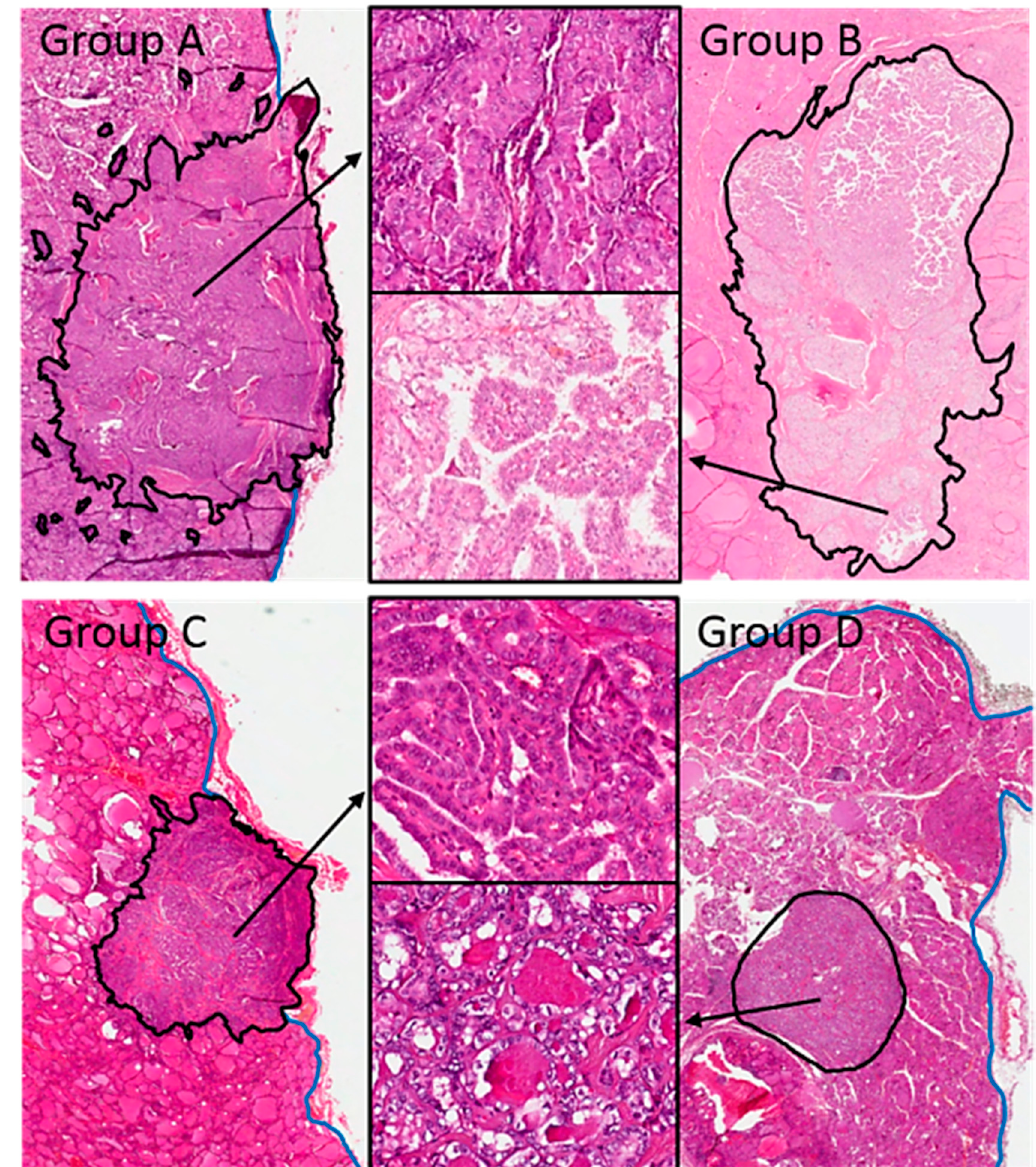
Figure 5. Histologic appearance of the microcarcinoma groups (hematoxylin and eosin sections). Group A (large subcapsular mPTC: size > or =5 mm and distance of the edge of the tumor from the thyroid capsule = 0 mm), group B (large nonsubcapsular mPTC: size > or =5 mm and distance of the edge of the tumor from the thyroid capsule >0 mm), group C (small subcapsular mPTC: size <5 mm and distance of the edge of the tumor from the thyroid capsule = 0 mm), and group D (small nonsubcapsular mPTC: size <5 mm and distance of the edge of the tumor from the thyroid capsule >0 mm). Low power appearance and histologic features at higher magnification (insets). The black lines outline the tumor border with the surrounding non-neoplastic tissue; the blue lines outline the capsular surface of the thyroid gland. Group A tumors represent the group with the most worrisome characteristics, and group D tumors that with the most indolent features.